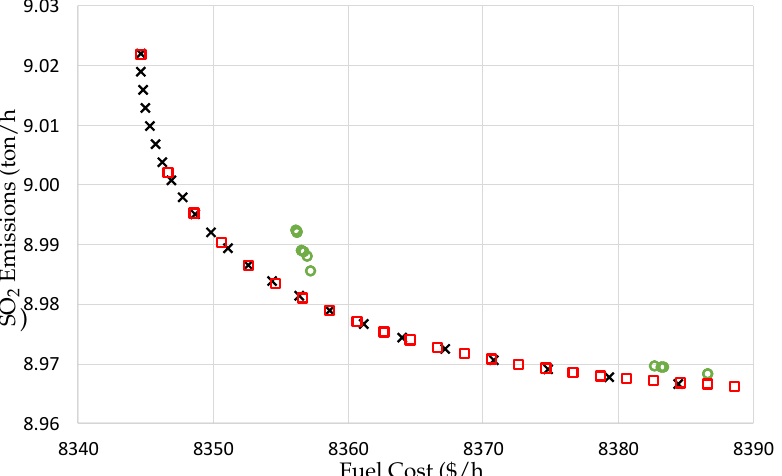
Figure 4. Pareto front for fuel cost and SO 2 emissions constructed using 25 elements. Red squares represent the sequential quadratic programming (SQP), green circles represent NSGA-II , and black × represent NPHC.